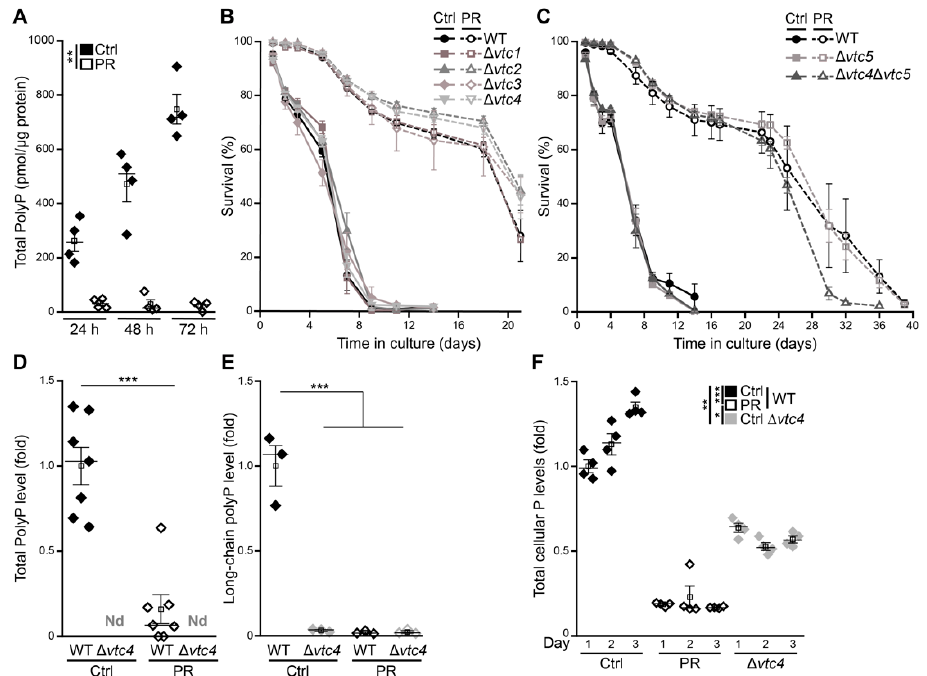
Figure 2. Polyphosphate as P i reservoir is dispensable for longevity induced by gradual phosphate exhaustion. ( A ) Polyphosphate levels in WT cells grown for 24 h, 48 h and 72 h on standard (Ctrl) or phosphate-restriction (PR) media; n = 4. ( B , C ) Survival during chronological aging of WT and deletion mutants in genes coding for subunits of the vacuolar transporter chaperone (VTC) complex ( ∆ vtc1 , ∆ vtc2 , ∆ vtc3 and ∆ vtc4 ) ( B ) and WT and ∆ vtc5, as well as the double-deletion mutant ∆ vtc4 ∆ vtc5 ( C ) grown in Ctrl or PR media, determined by flow cytometric analysis of PI staining; n ≥ 3. ( D ) Total polyphosphate levels in WT cells and cells lacking Vtc4 grown for 24 h on Ctrl or PR medium (N.D., not detectable); n = 8 for WT and n = 3 for ∆ vtc4. ( E ) Long-chain polyphosphate levels in samples described in ( D ); n = 3. ( F ) Total cellular phosphorus content (P) measured via total reflection X-ray fluorescence (TXRF) in WT and ∆ vtc4 cells grown in Ctrl or PR medium and harvested on days 1, 2 and 3. Values are presented as fold of WT Ctrl at day 1. N = 4. For statistical analysis, two-way ANOVA ( A , F ), unpaired- T -Test ( D ) and ordinary one-way ANOVA ( E ) were used. * p < 0.05, ** p < 0.01 and *** p <